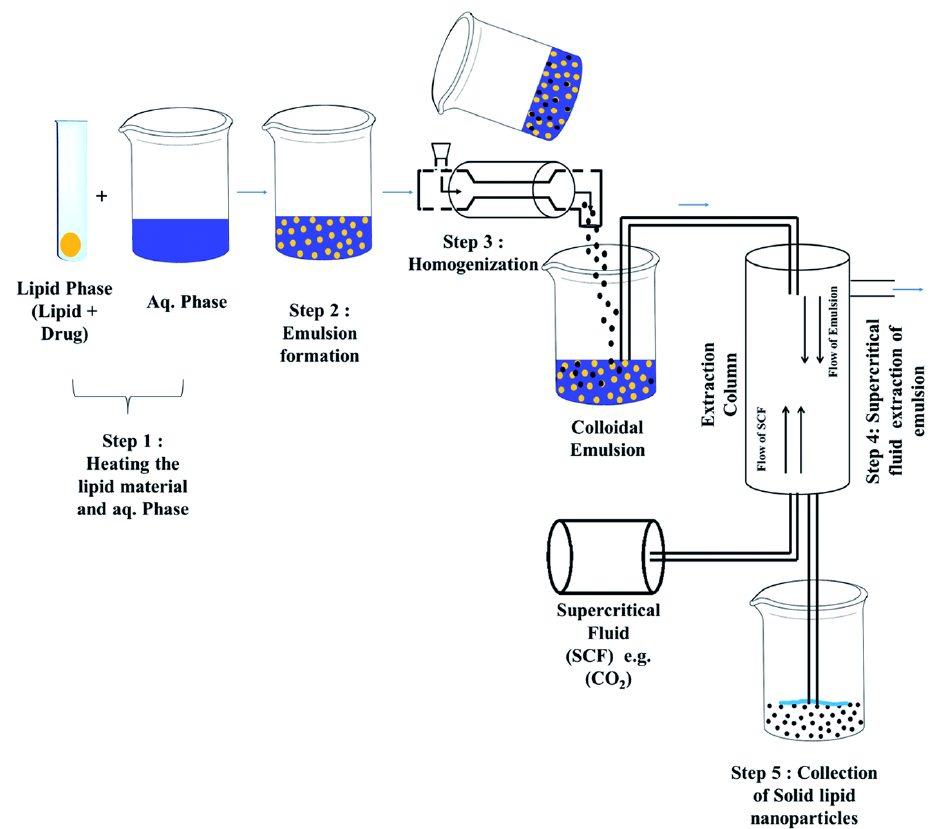
Figure 5. Supercritical fluid technique for the preparation of solid lipid nanoparticles. Reprinted from Ref. [17].